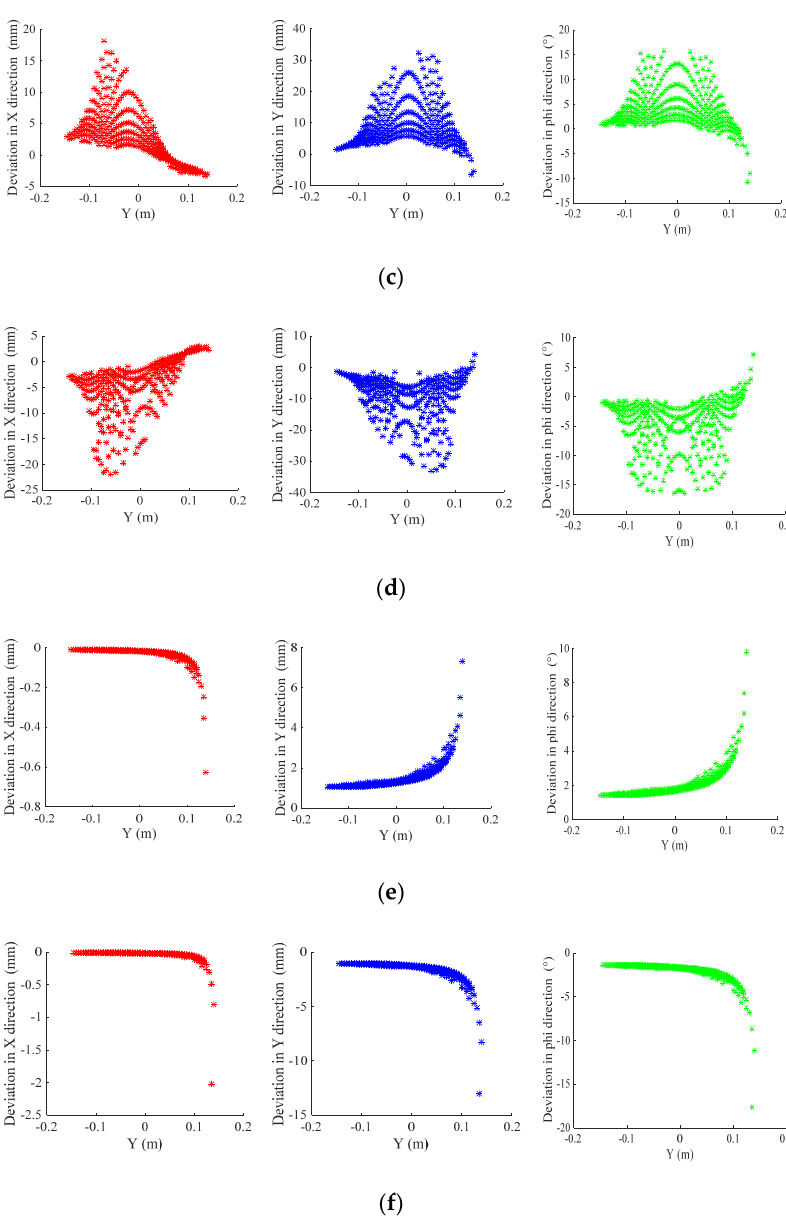
Figure 5. The influence of the cable length error on the tip positioning accuracy: ( a ) Adding − 1 mm error to the first cable; ( b ) adding +1 mm error to the first cable; ( c ) adding − 1 mm error to the third cable; ( d ) adding +1 mm error to the third cable; ( e ) adding − 1 mm error to the fifth cable; ( f ) adding +1 mm error to the fifth cable.